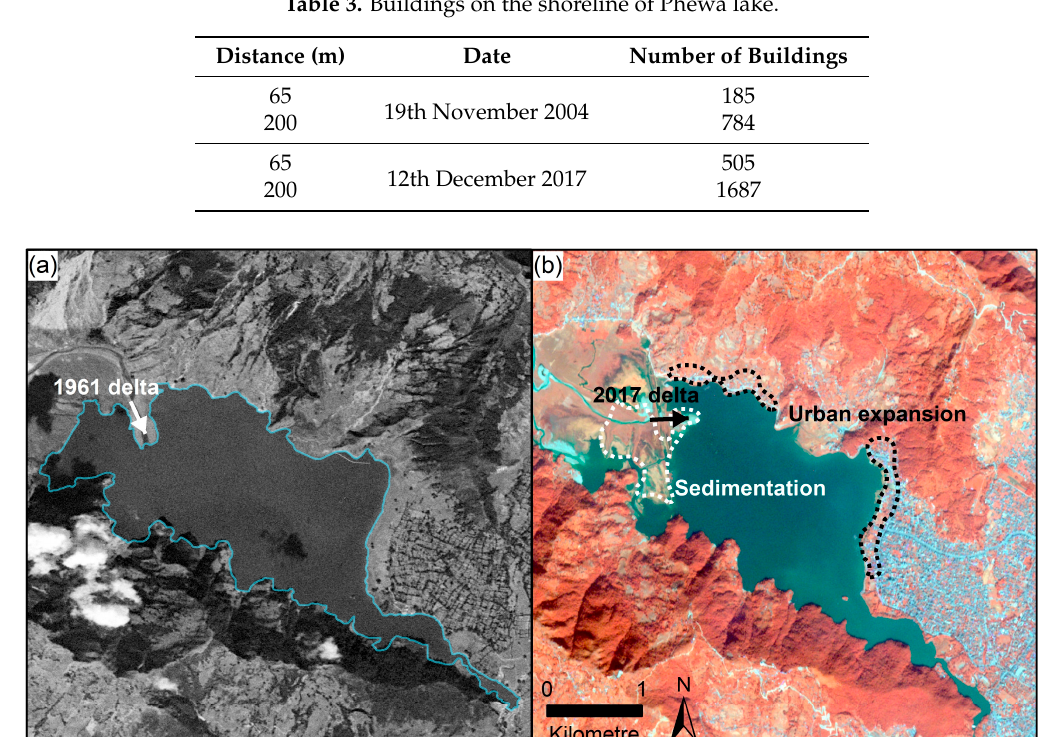
Figure 10. ( a ) Phewa Lake in 1961 with a panchromatic Corona satellite image background; ( b ) Phewa Lake in 2017 with a RapidEye image (10 November 2017) false colour composite background (bands: near-infrared, green, and blue).